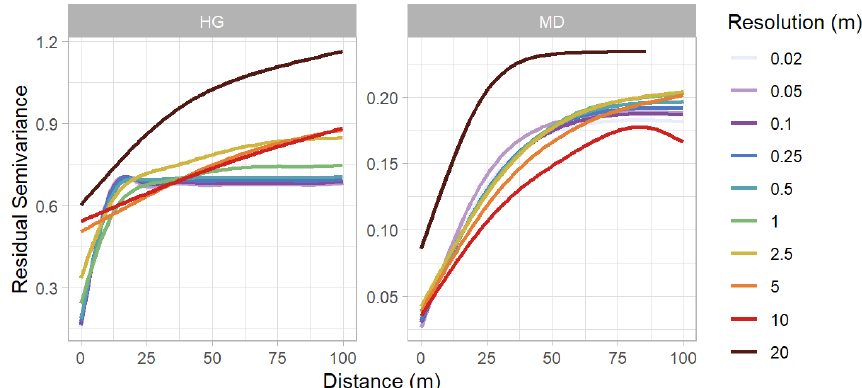
Figure 5. Seasonally averaged, spherical-fit variogram models from the Hourglass (HG) and meadow (MD) using the nearest-neighbor resampling method. Colors represent different resolutions. Note different y axis scales.